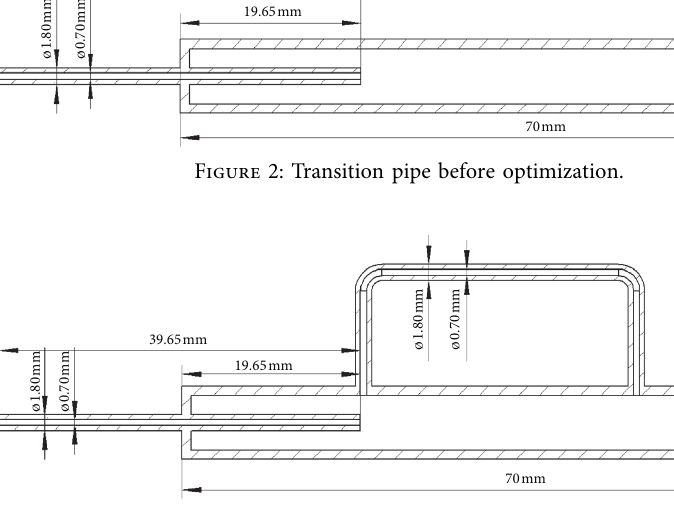
Figure 3: Transition pipe after optimization.